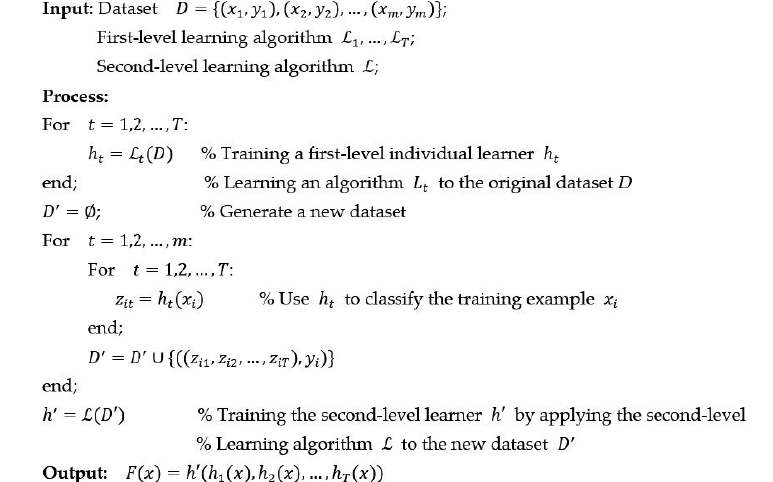
Figure 8. The algorithm of Stacking.